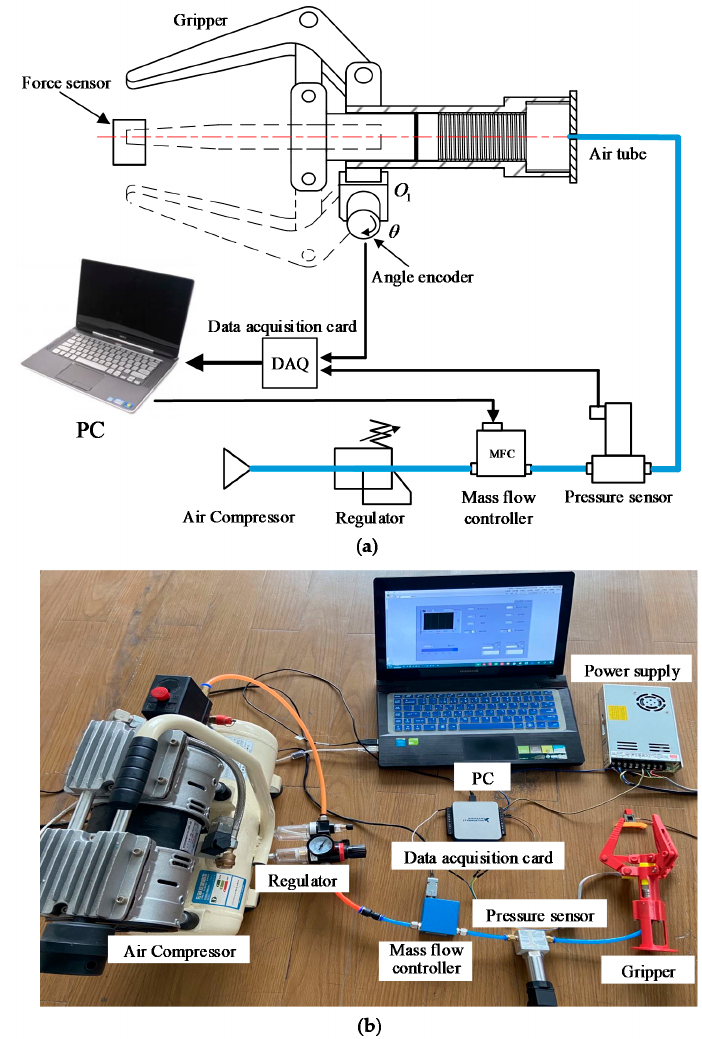
Figure 5. Experimental apparatus for control and measurement system of the gripper: ( a ) schematic of control and measurement system; ( b ) control and measurement system used in the validation test.